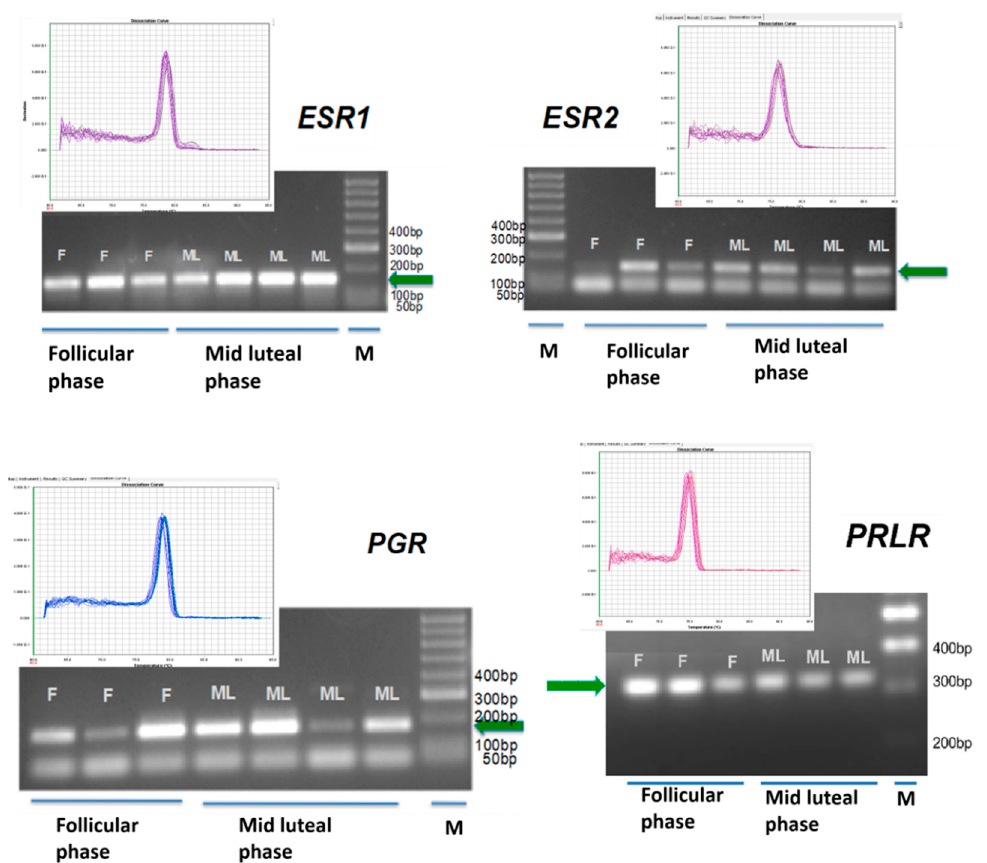
Figure 4. Qualitative PCR electrophoresis gel and dissociation curves of real-time PCR confirming estrogen receptor 1 ( ESR1 ), and 2 ESR2 , progesterone receptor ( PGR ) and prolactin receptor ( PRLR ) gene transcription in the IGS in different phase of the estrous cycle. Green arrow indicates the specific gene band. (F) follicular phase; (ML) mid luteal phase; (M) DNA marker; bp (base pairs). All primers validated for 80 nM in the real time PCR run. Single product confirmation with the single peak in the dissociation curve.